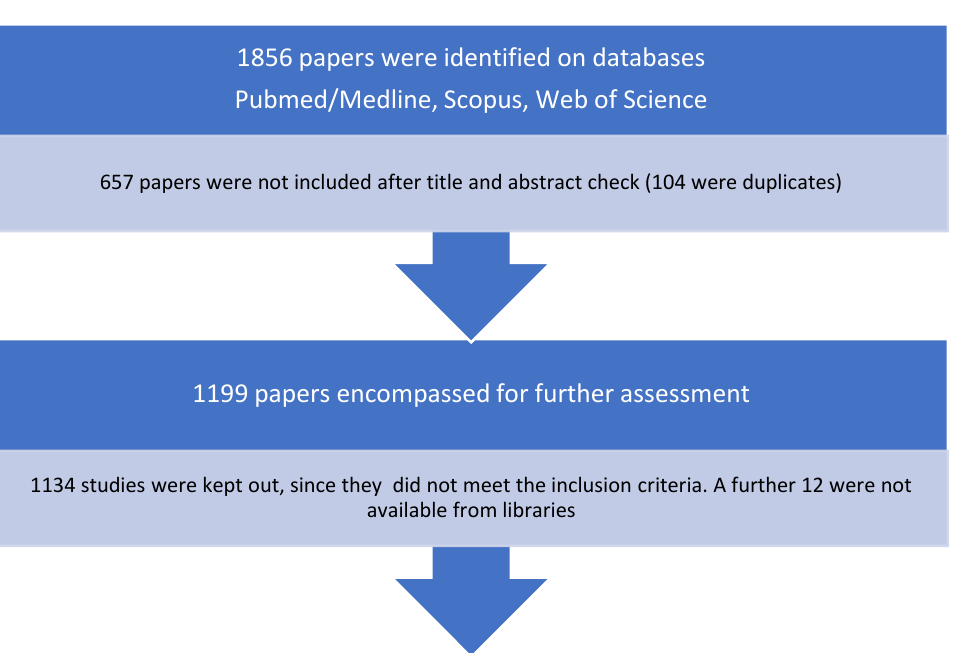
Figure 1. Flow diagram of the study selection process.